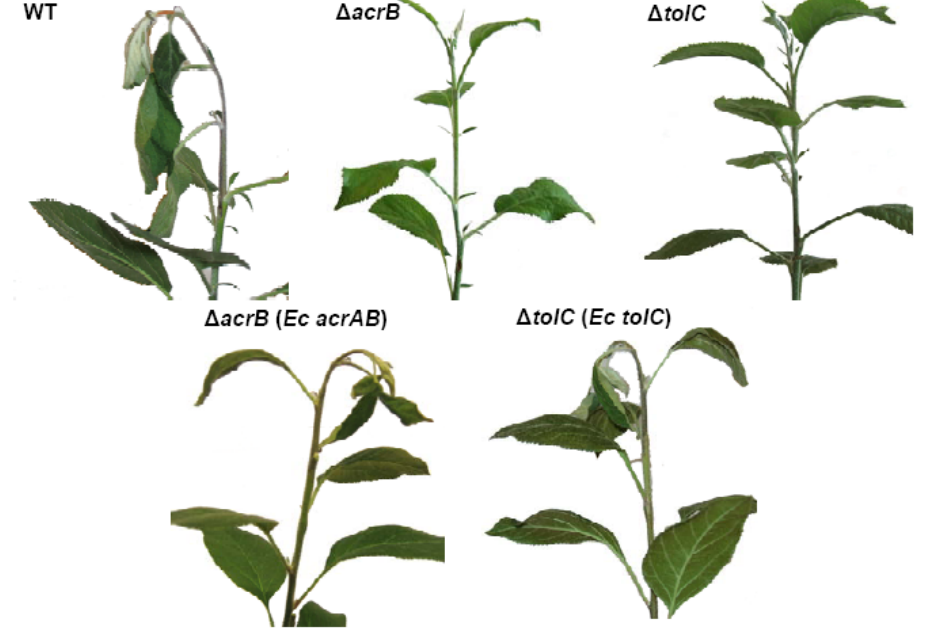
Figure 1 . Pathogenicity assay on apple plants. Shoot tips were inoculated with 5 µL of 1 x 10 7 CFU/mL bacterial suspensions. Disease symptoms such as the typical ‘shepherd’s crook’ formation and wilting developed on plants inoculated with E. amylovora wild type after one week of